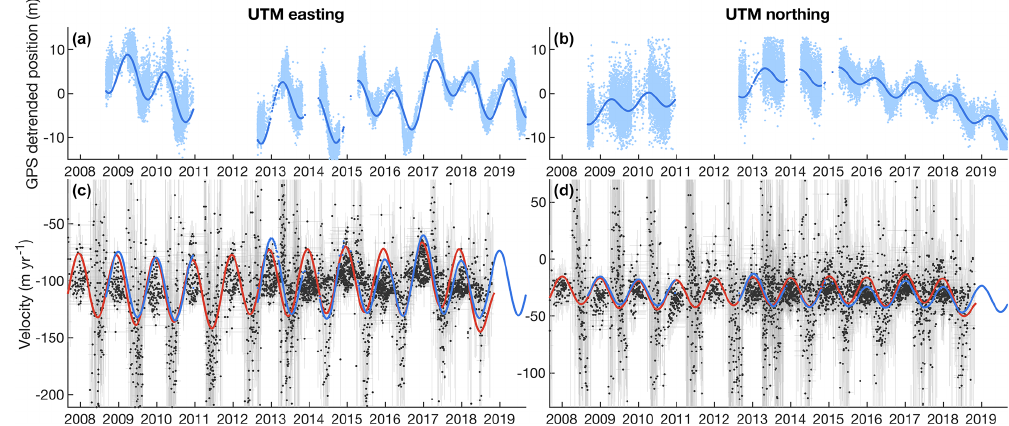
Figure 7. GPS validation at Russell Glacier, Greenland. Hourly time series of (a, b) detrended positions of a GPS receiver are shown as raw data in light blue and the sum of interannual variability and a sinusoid fit in dark blue. The amplitudes of positional seasonal variability are only 4.5m in the easting ( x ) direction and 1.8m in the northing ( y ) direction, yet these minor seasonal displacements are easily detected by applying the methods described in Sect. 3 to ITS_LIVE Landsat image pair velocities. (c, d) Velocity measurements from 5189 ITS_LIVE image pairs are plotted in gray, with our fit to the measurements in red. The blue velocity curves are simply the time derivatives of the corresponding GPS position curves plotted in panels (a) and (b) . The level of agreement between the two independent measurements is detailed in Table 2.